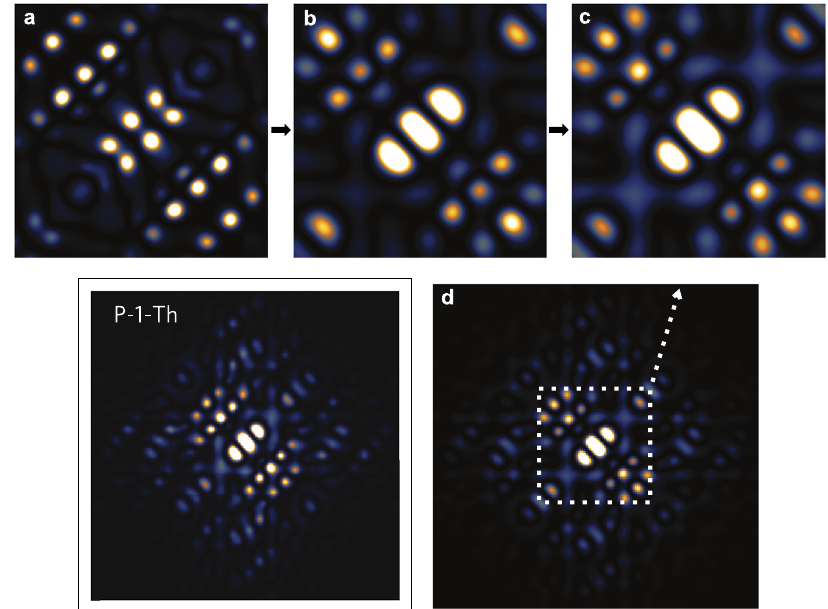
Fig. 2 Effect of tip orbital on STM images. All panels represent simulated STM images for a single P dopant at depth 4.75 a Si . The left image orbital alone, while the other two images ( b , c ) were each obtained with the same ( a ) was computed using Chen's derivative rule for a d z 2 (cid:1) 1 3 r 2 orbitals as described in the text. While the ( b ) image uses the standard forms of Slater-type generalized tip state, combining s, p z and d z 2 (cid:1) 1 3 r 2 orbitals, ( c ) and ( d ) images additionally use an optimized exponent for s* STOs (see the text). The additional, black-bordered picture (P-1-Th) showing the simulated data has been reprinted from ref. 3 (with courtesy from Springer Nature) for